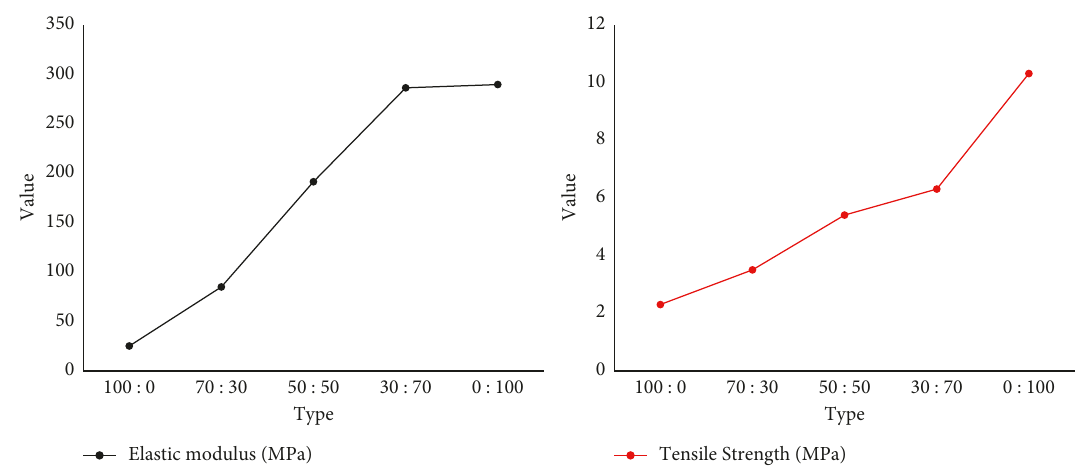
Figure 6: Tensile properties of SF collagen/PLLA fiber